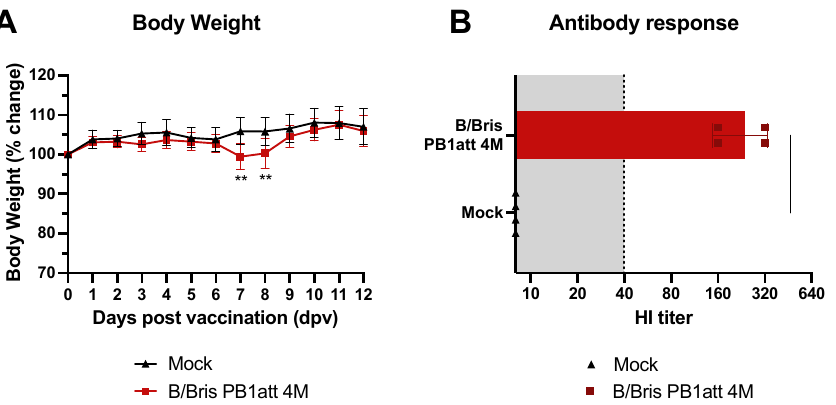
Figure 3. Safety and immunogenicity of the B/Bris PB1att 4M virus. DBA/2J 4-week-old, male and female mice were inoculated I.N. with either B/Bris PB1att 4M or PBS (mock group). ( A ) Percentage body weight change was evaluated daily for 12 days following vaccination. ( B ) Immunogenicity of the B/Bris PB1att 4M virus was measured by HI assay in mouse sera at 20 days post-boost (dpb). Shaded area indicates cutoff for HI titers considered to be predictive of protection. Weight loss data were compared using two-way ANOVA corrected for multiple comparisons using Holm–Sidak’s test. Significant differences, compared with mock group, are indicated. ** p < 0.01. Plotted data represent means ± standard errors.